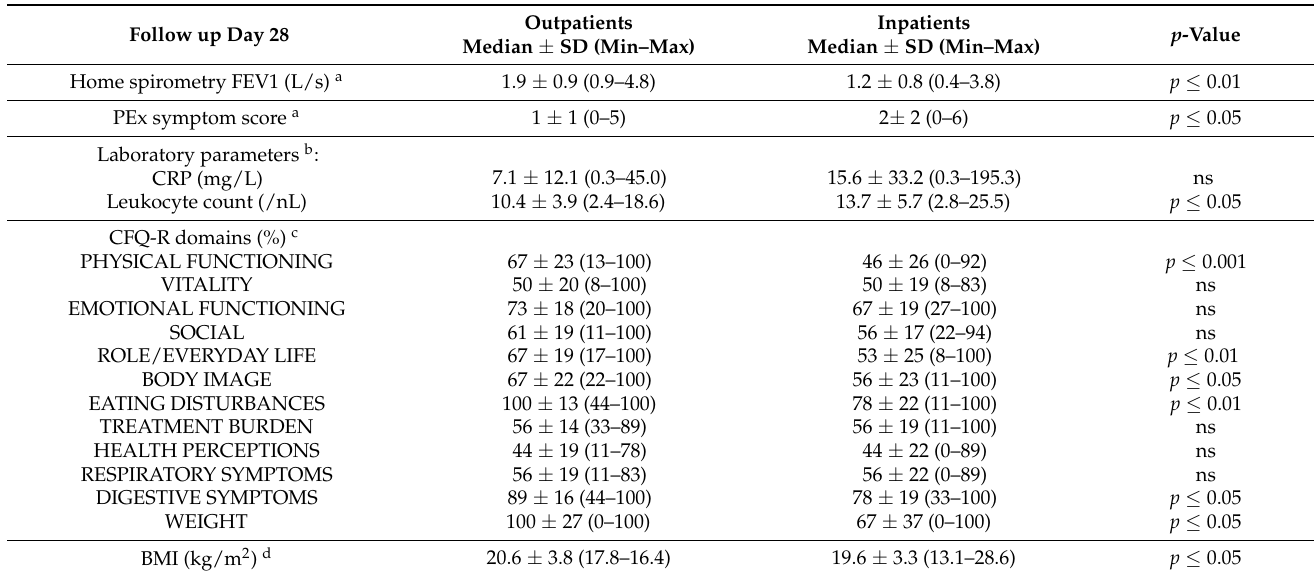
Table 4. Outcome day 28. Inpatient and outpatient analysis shown for patients with complete data on days 0 and